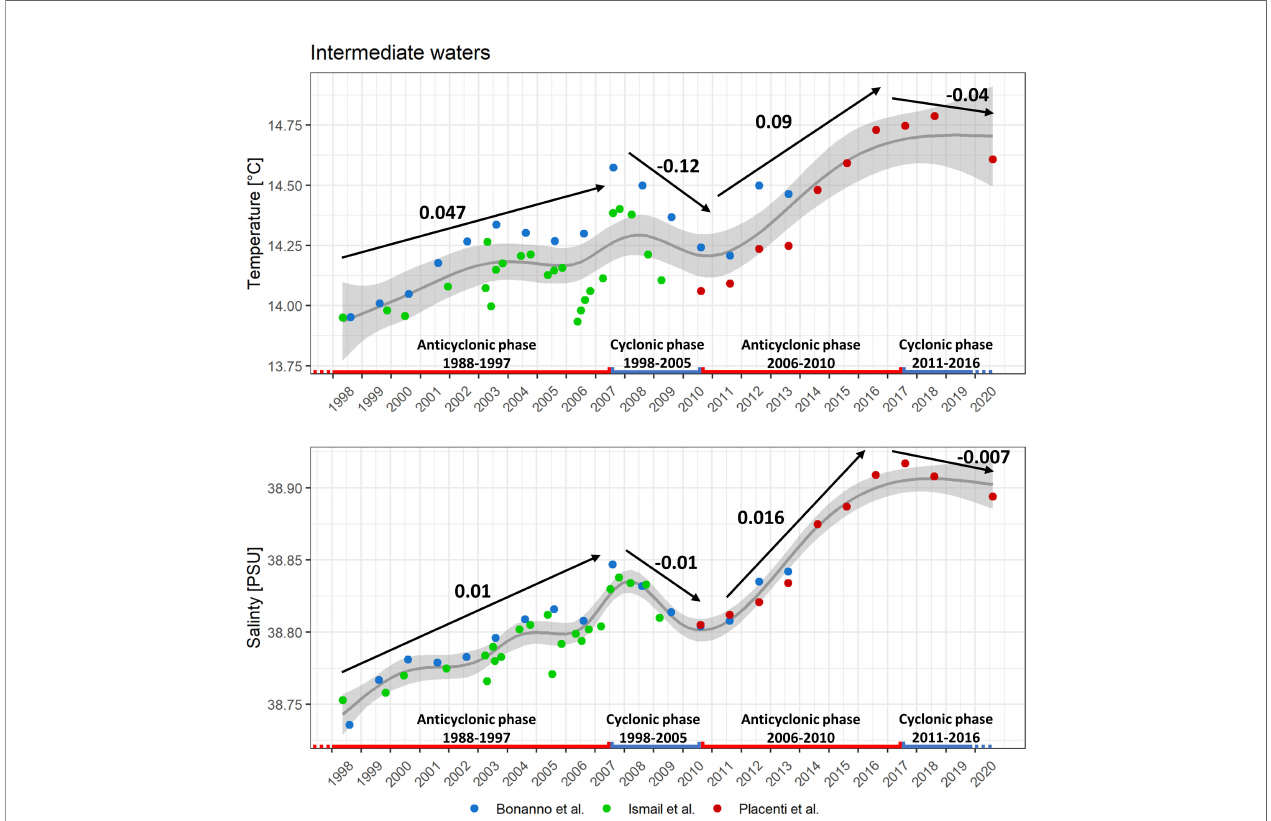
FIGURE 6 | Temperature (top panel) and salinity (bottom panel) time series of the LIW, extrapolated by Ben Ismail et. (201)4 and Bonanno et al. (2014), are indicated as green and blue dots, respectively. Potential temperature and salinity time series from this study are indicated as red dots. A cubic regression spline computed through a GAM model and the relative con fi dence interval has been added in gray with the aim at evidencing temporal trends. Black arrows indicate the average annual increments of hydrological parameters computed for 1998-2009 by Bonanno et al. (2014) and for 2010-2020 from data collected in this study. The position of the dots on the time axis takes into account the sampling